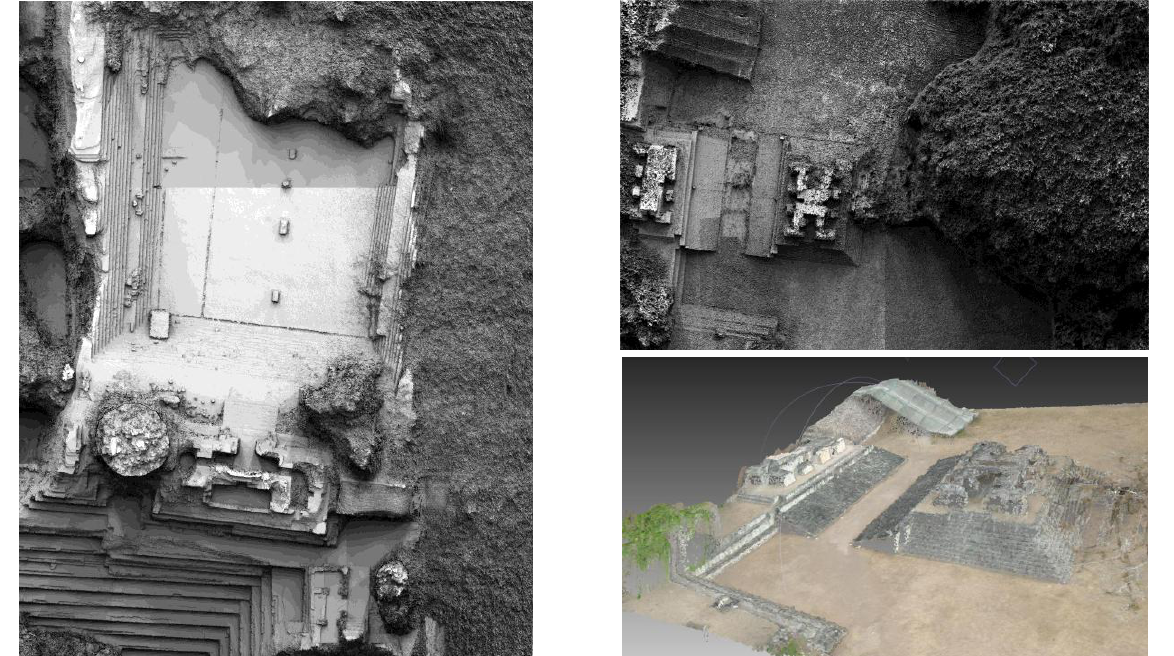
Figure 5: Produced DSM over the entire East Court in Copan (left) and a closer view of the reconstructed Ball Court (shaded and color mode) inside the Main Plaza (right).